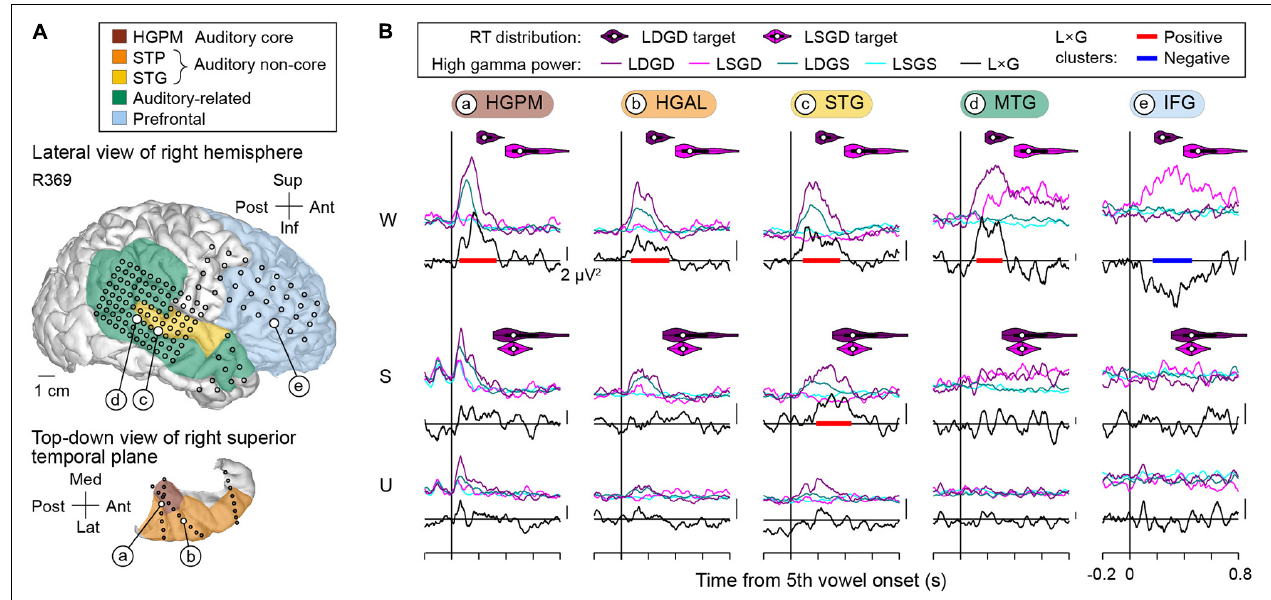
FIGURE 5 | L × G interactions during the induction of general anesthesia in a representative subject with right hemisphere electrode coverage (R369). (A) Lateral view of the right hemispheric surface and top-down view of the STP depicting electrode coverage. Colors represent different ROIs, circles represent recording sites. Larger white circles denote the locations of five representative recording sites (a–e). (B) High gamma responses to the final vowel of the LGD quintuplet stimulus recorded from the exemplary sites (a–e, left to right) and L × G interactions in awake, sedated, and unresponsive states (W, S, U; top to bottom). Across-trial average high gamma power envelopes are shown separately for the four stimulus conditions (LSGS, LDGS, LSGD, and LDGD; cyan, teal, magenta, and purple, respectively). Black lines denote L × G interaction time course, baseline-corrected by subtracting mean value over the 600 ms prior to the onset of the 5th vowel. Vertical scale bars correspond to 2 µ V 2 . Significant ( p < 0.05) positive and negative L × G interaction clusters are shown as red and blue bars, respectively. RT distributions for LSGD and LDGD target stimuli are shown as magenta and purple violin plots, respectively. In each violin plot, a white circle denotes the median, a vertical line denotes the mean, a bar denotes Q 1 and Q 3, and whiskers show the range of lower and higher adjacent values (i.e., values within 1.5 interquartile ranges below Q 1 or above Q 3,